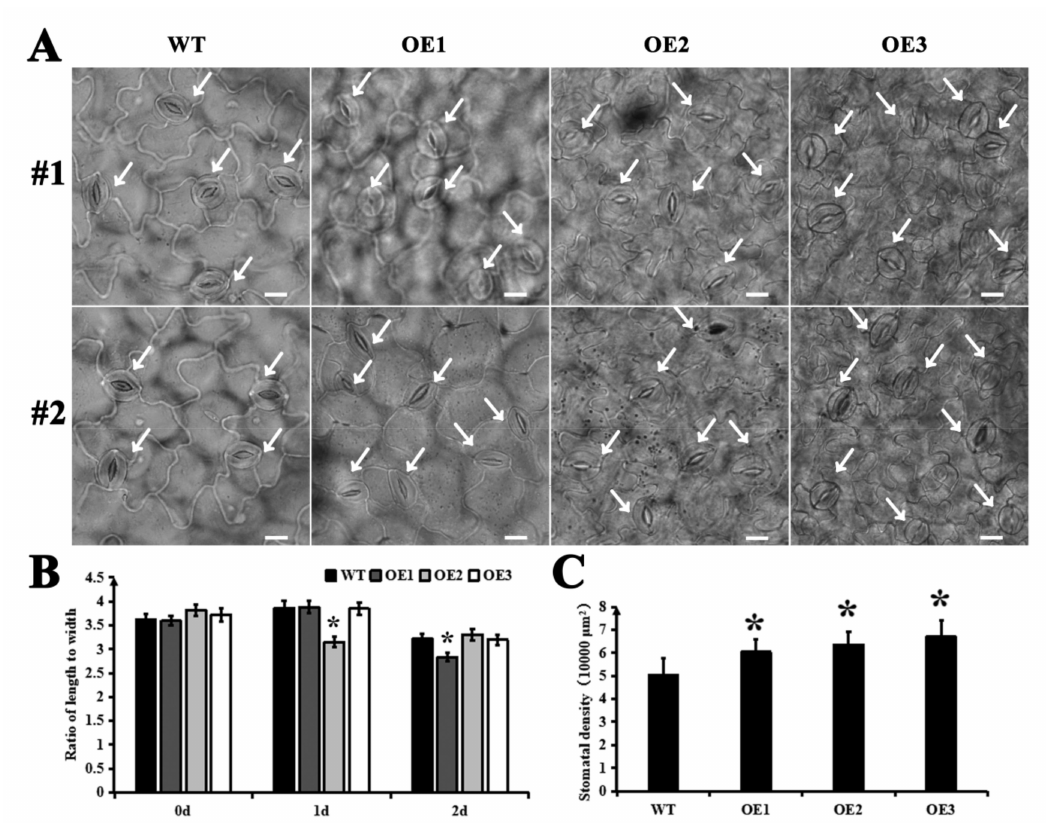
Figure 5. Stomatal density, opening degree of lower epidermis leaves in Arabidopsis seedlings after hyperosmotic treatment (10% PEG 6000). ( A ) The in situ detection of stomatal distribution on the lower epidermis of WT, OE1, OE2 and OE3 leaves via light microscope. #1 and #2 represent different fields of vision. The white arrows indicate stomatal. Per unit area 1 × 10 4 µ m 2 . Bars = 10 µ m. ( B ) Stomatal closure quantified by measuring the length to width ratios of stomata in a triplicate experiment with 100 pairs of guard cells per experiment. ( C ) Stomatal distribution density in the lower epidermis of Arabidopsis leaves. WT, wild type; OE1, overexpression line 1; OE2, overexpression line 2; OE3, overexpression line 3. * represents significant difference at p < 0.05 versus the wild type. The results were obtained from three biological experiments with three technical